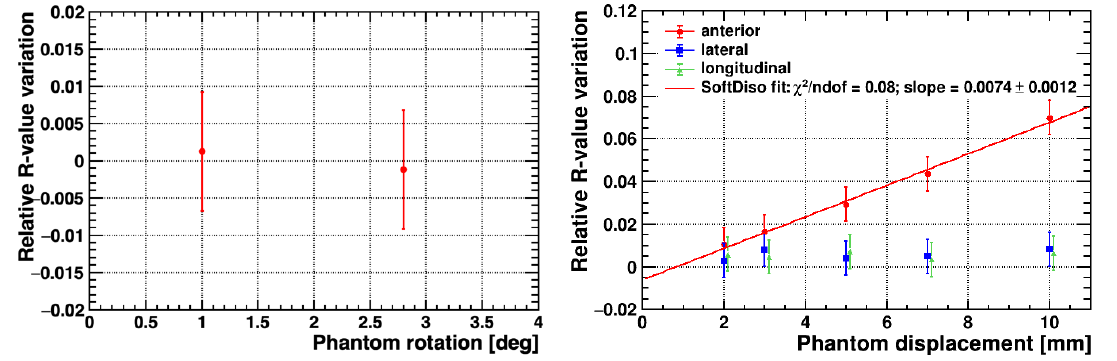
Figure 5. Deviations from reference values of the SoftDiso R-value for phantom rotations ( left ) and translations ( right